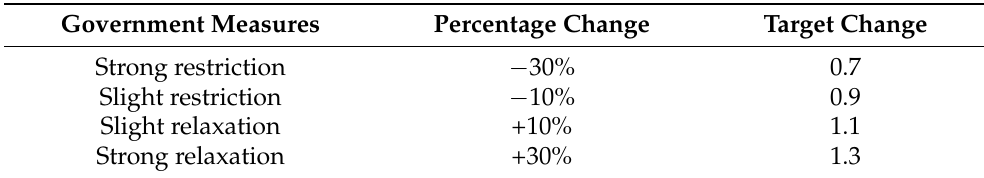
Table 2. Percentage of change according to the type of measure applied, based on the date from the measures taken in Caldas (Figure